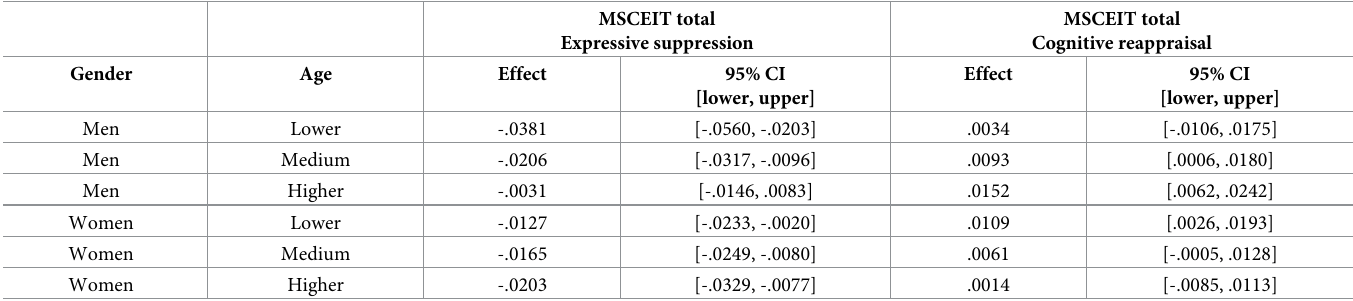
Table 1. Conditional effect of age and gender on the relationship between total MSCEIT and expressive suppression, and between MSCEIT understanding and cog- nitive